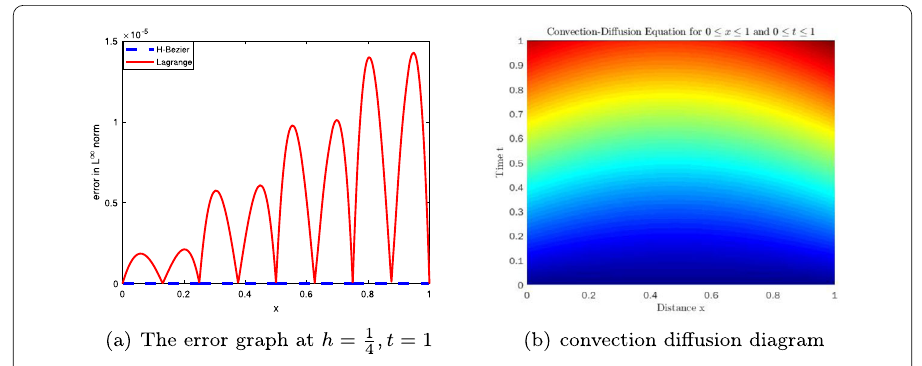
Figure 8 The error graph and convection diffusion diagram